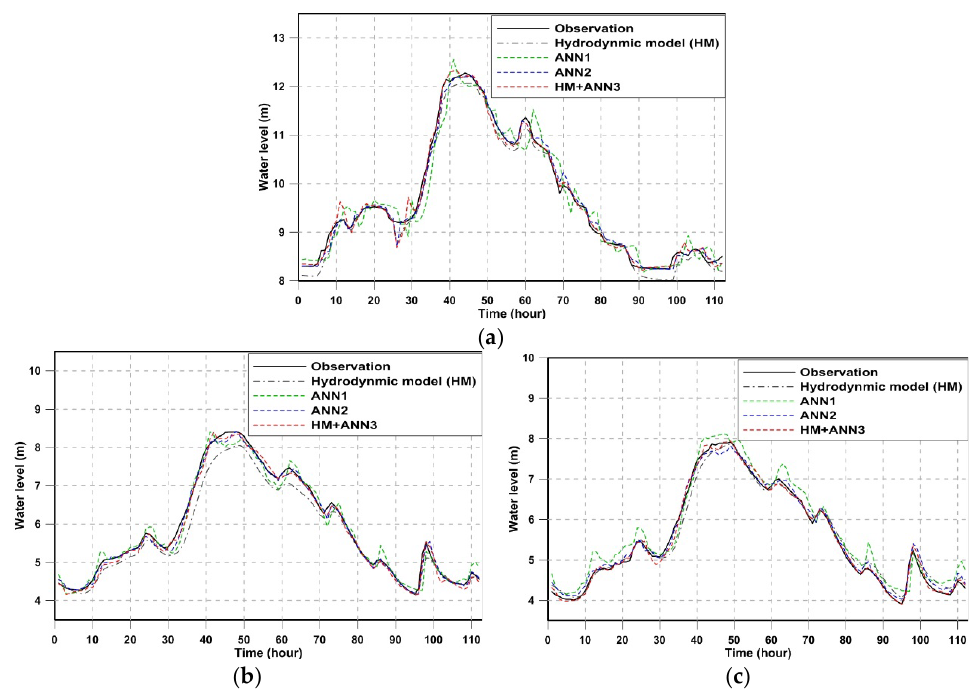
Figure 12. Three-hour lead time water levels calculated by various forecasting models for flood event 2 (15 July 2004–19 July 2004): ( a ) Paldang Bridge; ( b ) Banpo Bridge; ( c ) Hangang Bridge. Two statistics, i.e., the Nash–Sutcliffe efficiency coefficient (NSE) and RMSE, were used to evaluate the accuracy of different forecasting models. The values of two statistics for training periods are summarized in Table 6, and the best results for each location according to each performance metric are highlighted in bold. NSE and RMSE indicate that the hydrodynamic model alone has relatively low accuracy compared to other forecasting models. Forecasting the accuracy of ANN1 decreases with the longer lead time of forecasting, which is naturally expected as ANN1 only uses the historical observations to forecast water levels. Forecasts by the hybrid approach are most accurate at the Paldang Bridge, while ANN2 also shows good performance at the Banpo Bridge and Hangang Bridge. Table 6. Statistical comparison of model performances for the training periods. Station Lead Time 0.988 The validation results are shown in Table 7 and the best results are also highlighted in bold. It is immediately obvious from the table that the hybrid approach is the most accurate based on the RMSE and NSE when applied to all three locations, and the accuracy